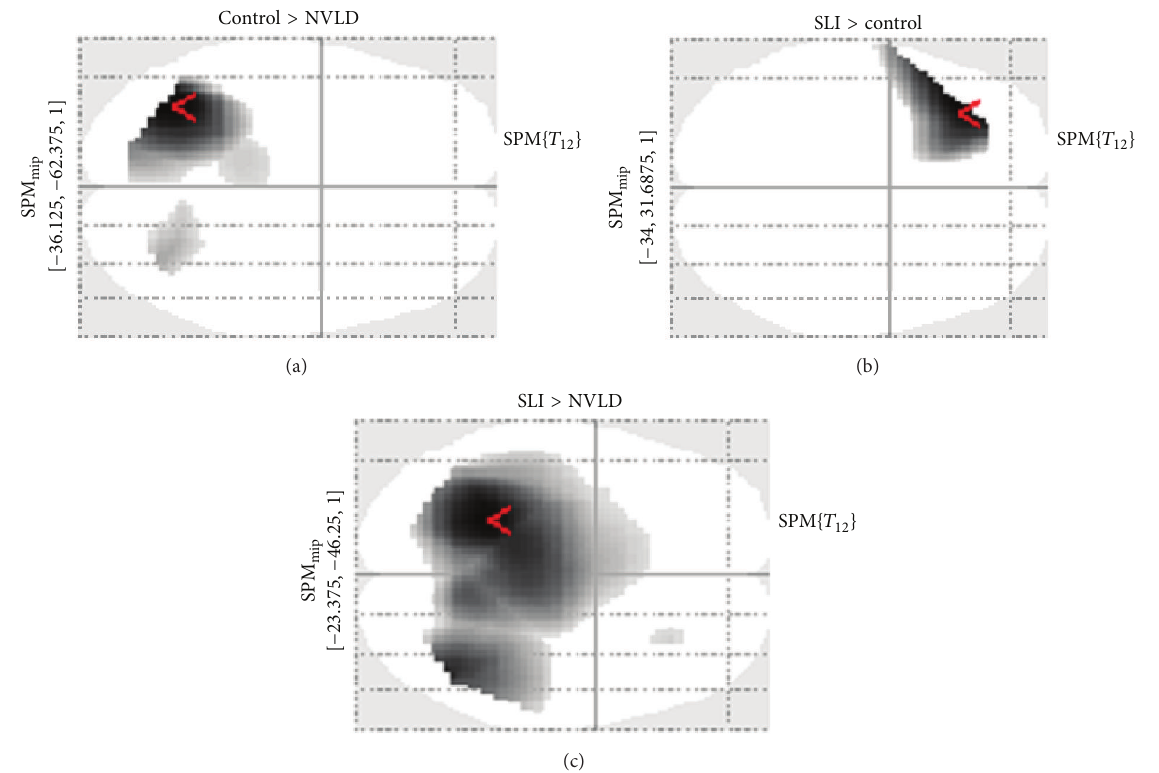
Figure 10: Across-groups SPM contrasts. (a) Control group versus NVLD. (b) SLI versus control. (c) SLI versus NVLD.